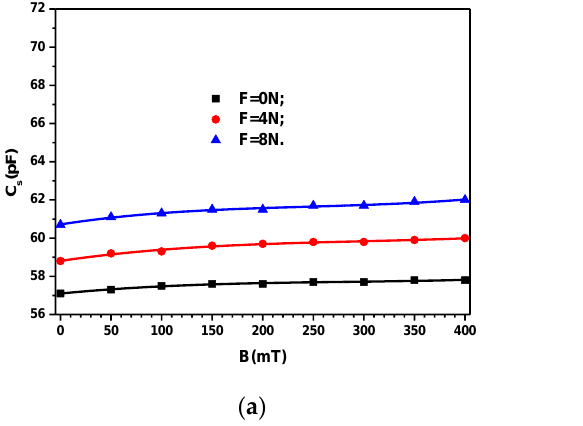
Figure 7. Loss tangent D S of the devices ED as a function of values B of the magnetic flux density superimposed on the electric field with the frequency f = 1 kHz, and values F of the force as a parameter. ( a ) MC 1 . ( b ) MC 2 . The obtained results lead us to the conclusion that the equivalent electrical scheme consists of a capacitor of capacitance C S in series with a resistor of resistance R S . Among these quantities, the following relation holds 𝑅 S = (2π𝑓𝐶 S 𝐷 S ) −1 . Since the range of C S shown in Figure 6 is of the order of pF, then the expression for the resistance can be written as: 𝑅 S (MΩ) = 10 3 2π𝑓(kHz)𝐶 S (pF)𝐷 S (1) where f is the frequency of the electric field, and C S and D S are the equivalent capacitance and resistance of ED, respectively. By using the value f = 1 kHz, and the values C S and D S from Figure 6, and Figure 7, respectively, one obtains, in Figure 8a,b, the variation of resistance with magnetic flux density for the composites MC 1 , and MC 2 , respectively.